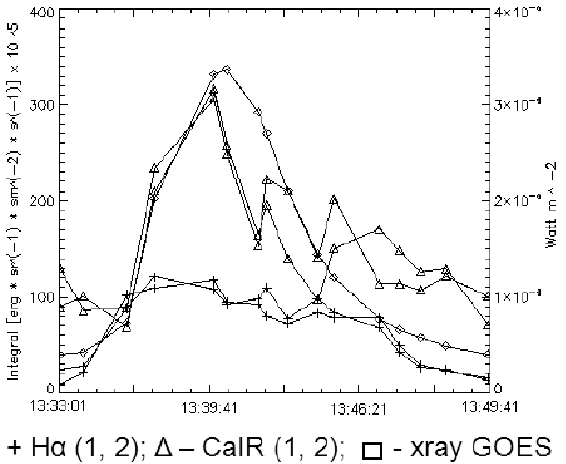
Figure 2. Graph of the intensity of two flare nuclei in the lines: (+) H α , (triangle) Ca 8542 Å, (rhomb) X–ray.